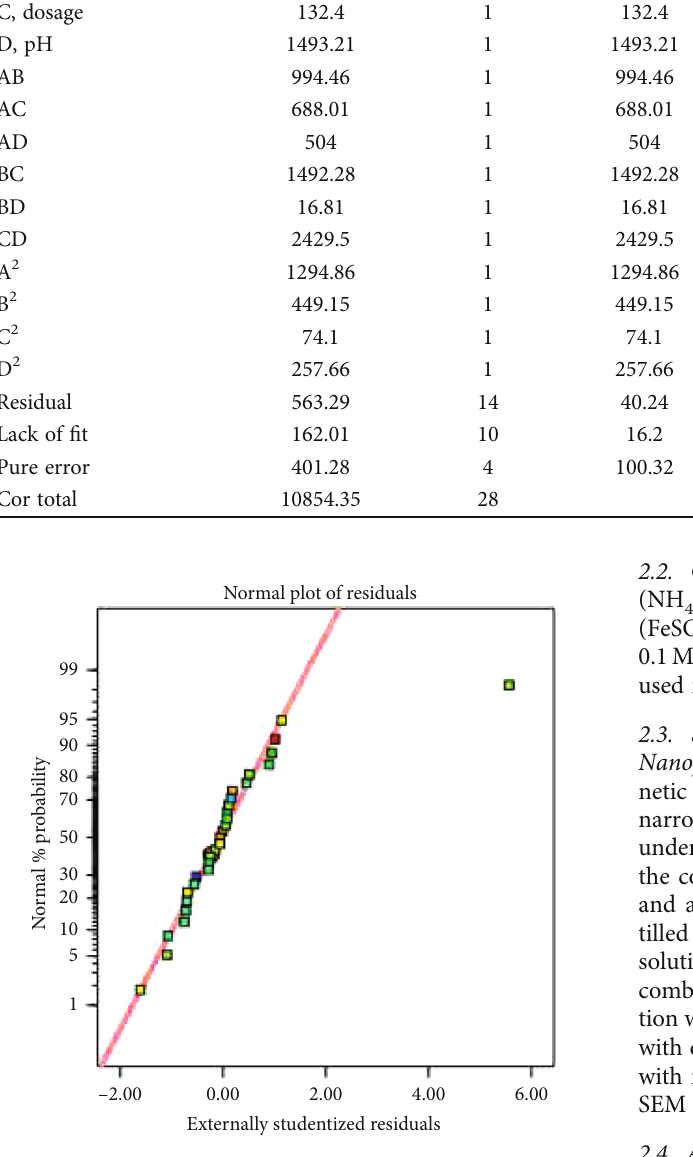
Figure 1: Experimental vs. predicted